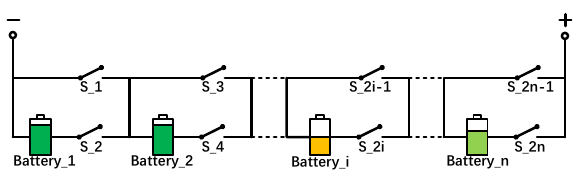
Figure 2. Initial state of SOC.